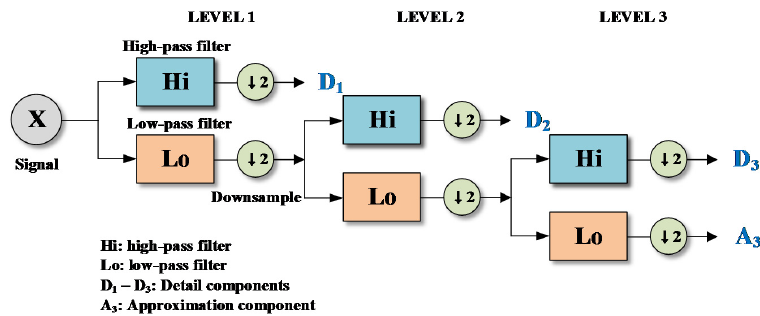
Figure 2. Flowchart for three-level DWT.